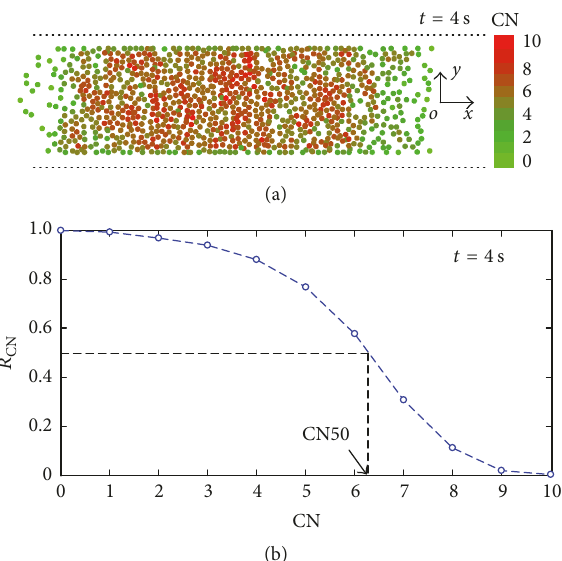
Figure 14: (a) The CN distribution of particles in the trough and (b) the CN distribution curve and the median CN (CN50).